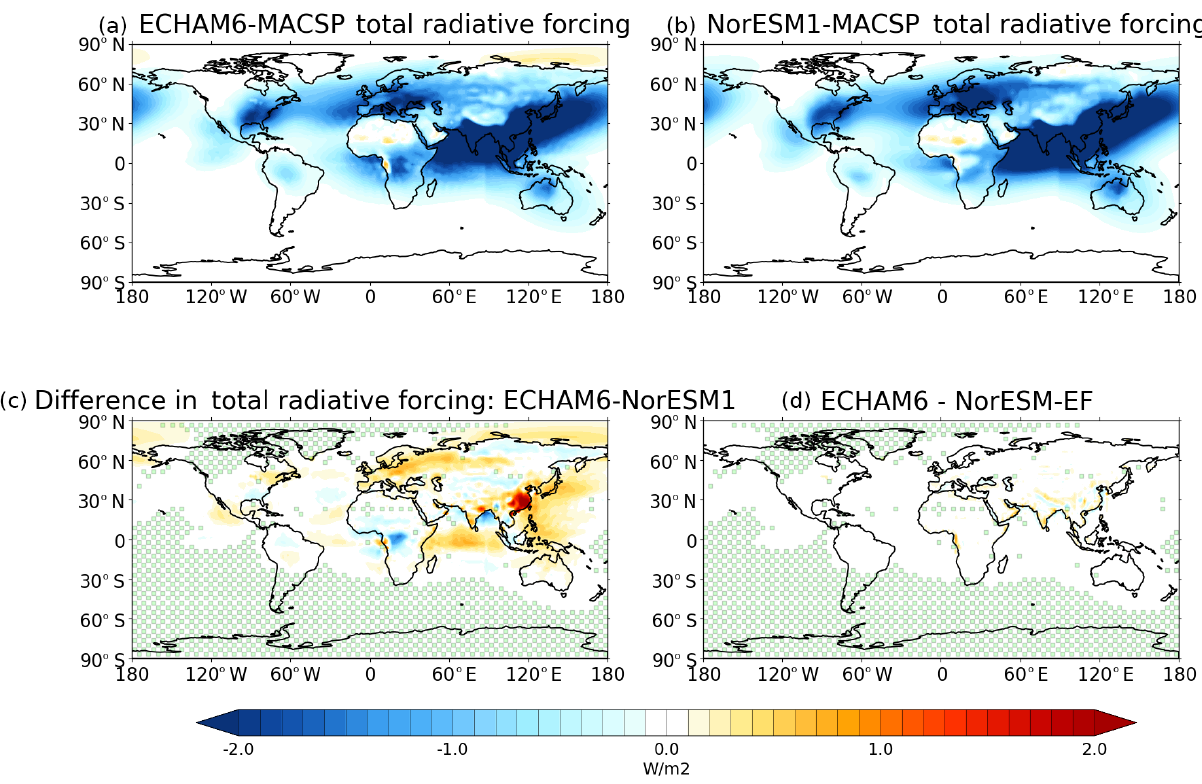
Figure 1. The total radiative forcing at top of the atmosphere produced by MACv2-SP aerosols. Panel (a) shows the forcing in ECHAM6- MACSP experiment and (b) in NorESM1-MACSP experiment. Panels (c) and (d) show the difference in forcing between the two models and difference between ECHAM-MACSP and NorESM1-EF runs. Small green circles mask the areas where results are not statistically significant at the p < 0 . 05